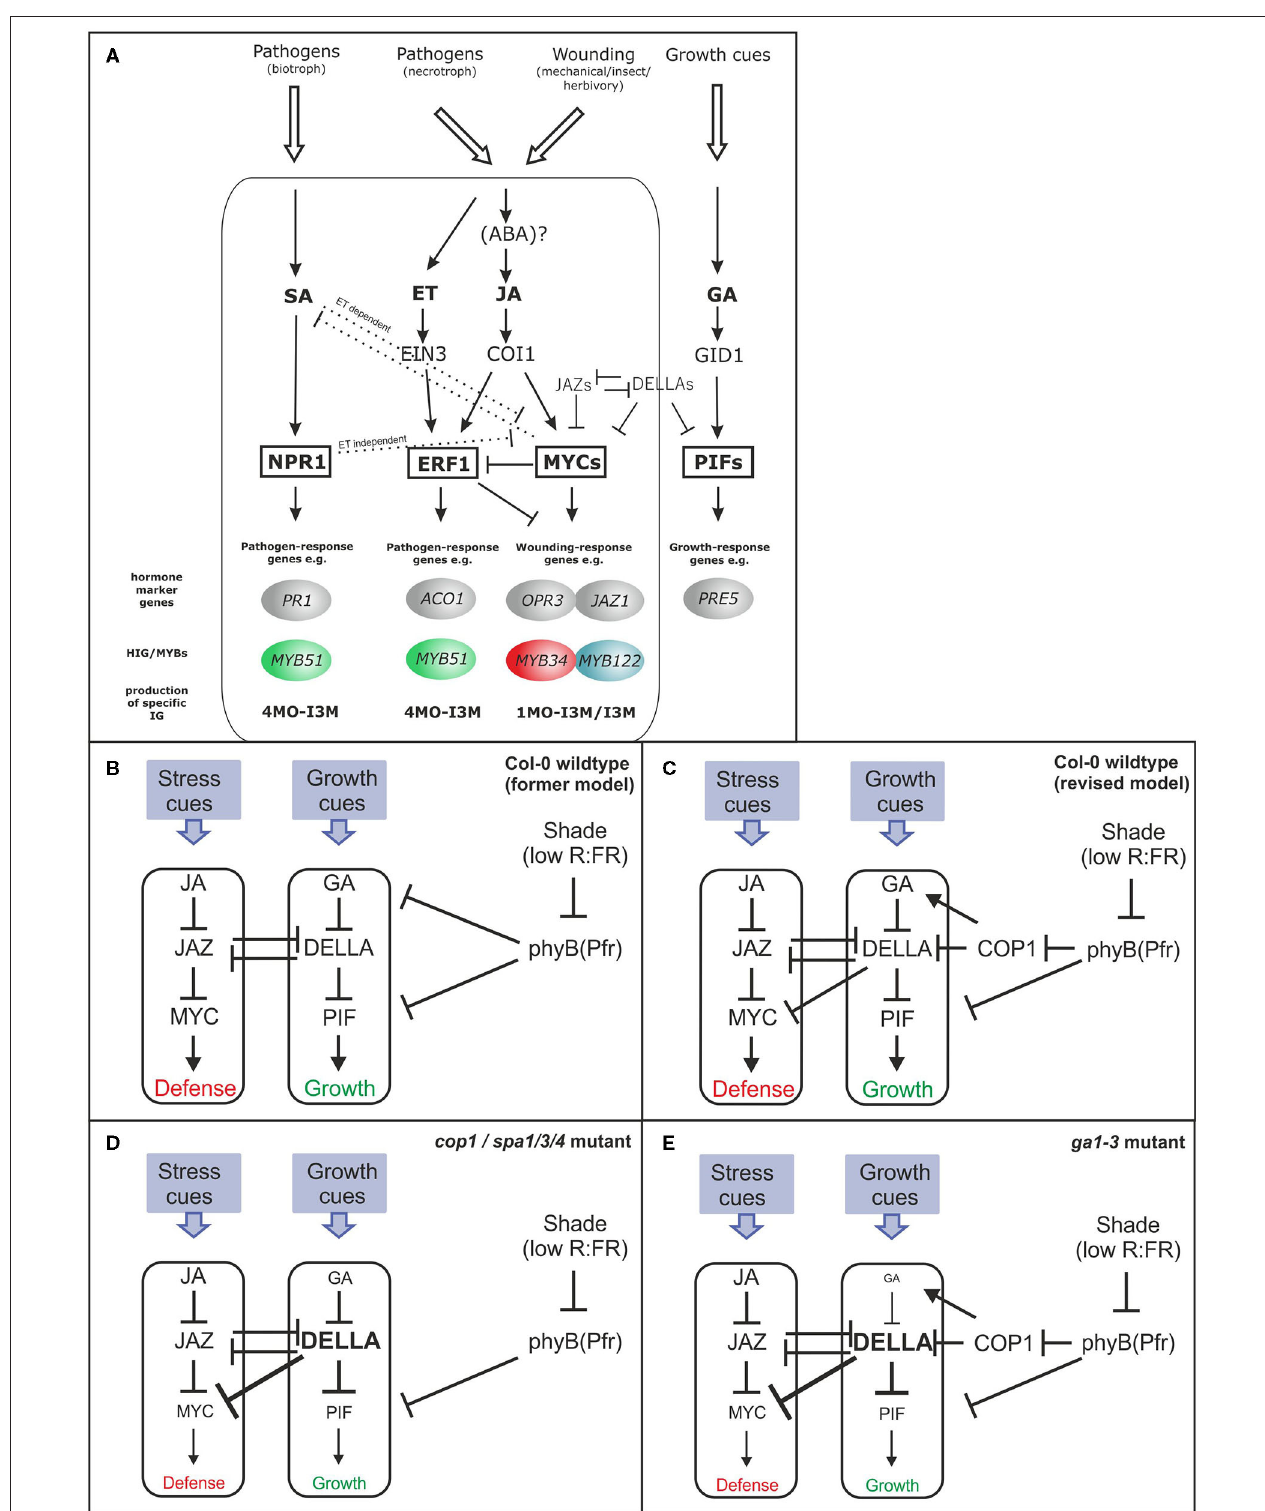
FIGURE 1 | Model for the hormonal signaling network in glucosinolate (GSL) regulation (A) and simplified model linking growth and defense trade-off (B–E) . The figure depicts the postulated simplified hormonal signaling cascades in Arabidopsis thaliana in response to different pathogens involved in the regulation of the HIG-MYBs and the corresponding hormone marker genes. Different biotic/abiotic challenges activate different phytohormone signaling cascades and, thereby, a specific